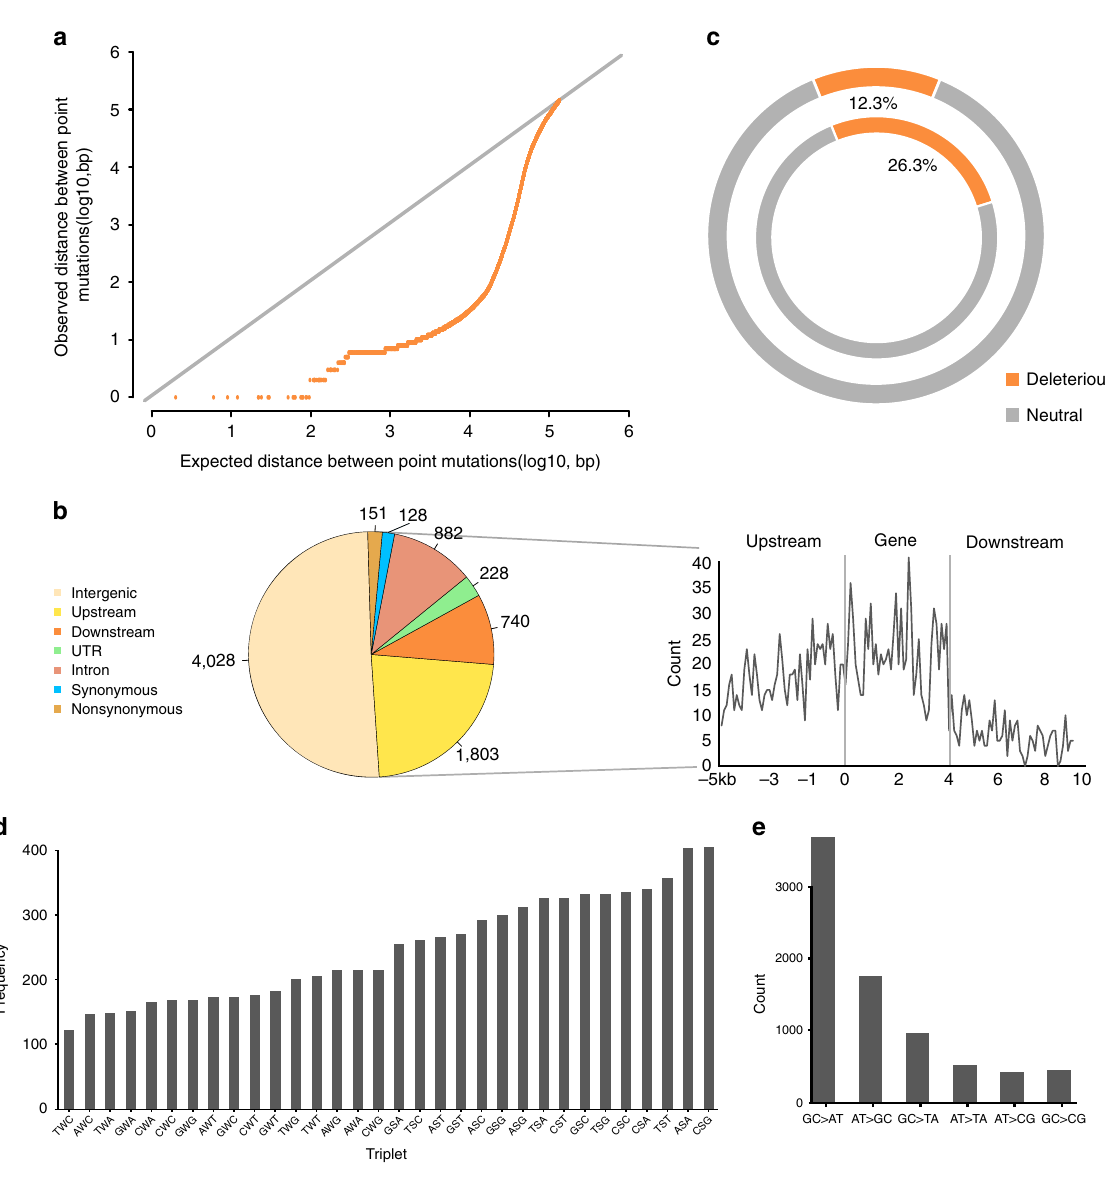
Fig. 4 The characteristics of spontaneous mutations. a The distribution of mutations was not random. The distances between adjacent mutations (observed, orange) against a random distribution of mutation across the genome (expected, gray). b The proportion of deleterious mutations in centromeres (the inner circle) and chromosome arms (the outer circle) are shown in orange. c The distribution of mutations by functional classi fi cation. The relative positions of mutations in gene regions were normalized referring to an average length (4 kb) based on B73 gene models 4 . d Variation in mutation rate of different triplets. e The mutation number of transitions and